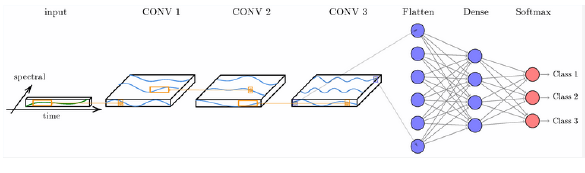
Figure 2. TempCNN model (Pelletier et al., 2019b)